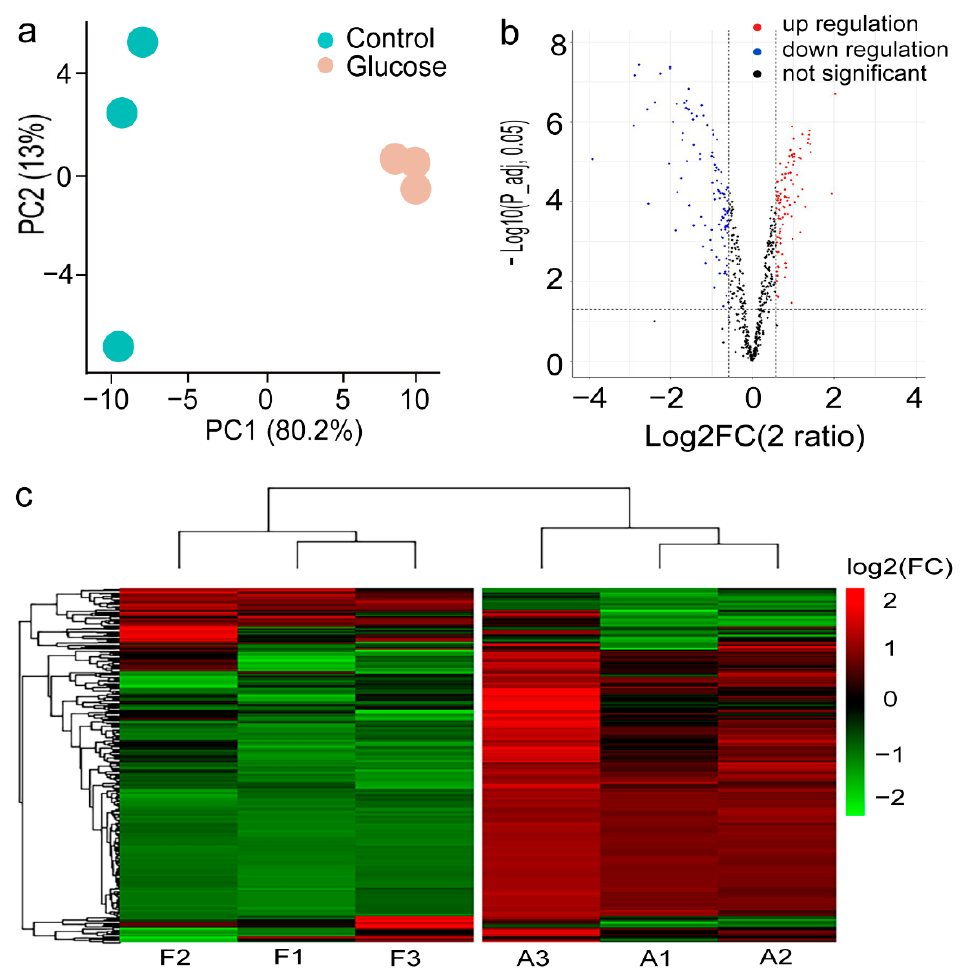
Figure 2. Proteomic analysis of proteins for Chromochloris zofingiensis in response to glucose addition by the TMT technique. ( a ) Principal component analysis of the identified proteins. ( b ) Volcano figure of the quantified proteins. The dash line represents the threshold of significant variance (adjusted p -value < 0.05), the red dots show the upregulated proteins (log2 (fold change) > 0), the blue one is the downregulated protein (log2 (fold change) < 0), and the black points indicate no significant protein change. ( c ) Hierarchical clustering analysis of all the differentially expressed proteins. F means with glucose, A means without glucose, and 1–3 indicate the biological replicates.